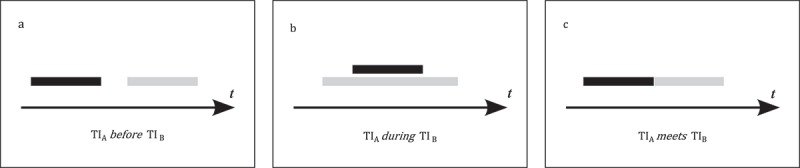
Three examples for Allen’s temporal logic (based on Allen 1983).